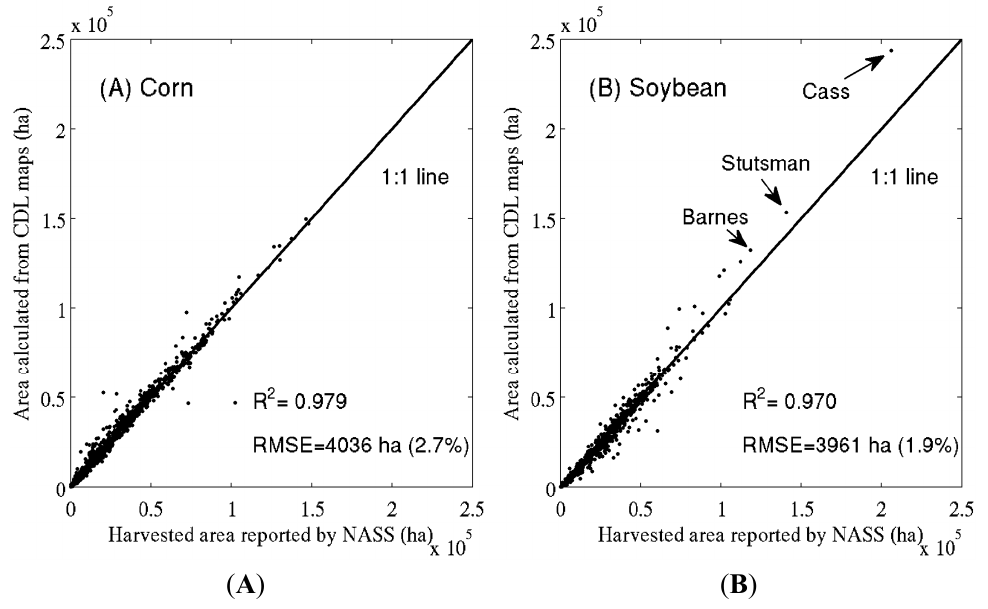
Figure 4. Comparisons between crop areas calculated from CDL maps and reported by NASS in 2011 for counties in the Midwestern US. ( A ) Corn area estimates; ( B ) Soybean area